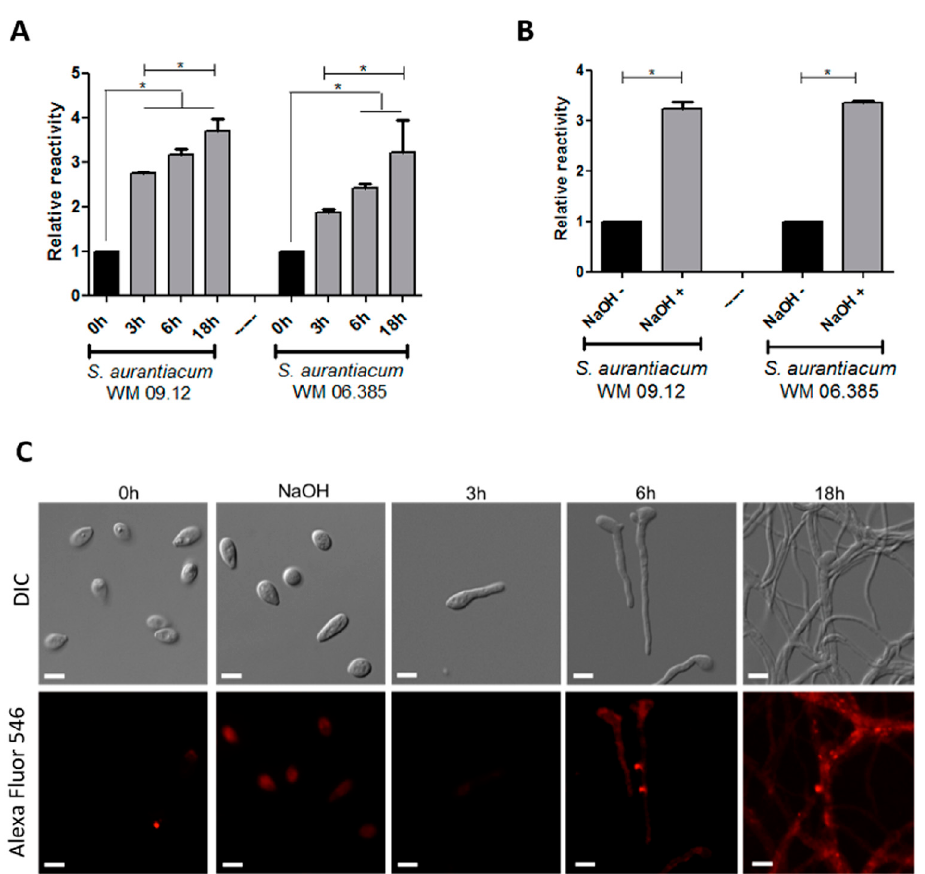
Figure 2. GlcCer exposure on S. aurantiacum WM 09.12 and WM 06.385 cell surface detected by monoclonal anti-GlcCer antibody. ( A ) ELISA of anti-GlcCer (100 µg/mL) bound to S. aurantiacum cells during different germination time points and ( B ) to conidia after treatment with NaOH 1M. ( C ) Immunofluorescence analysis of anti-GlcCer (100 µg/mL) reactivity to S. aurantiacum WM 06.385. Scale bar: 5 µm. * p < 0.05.